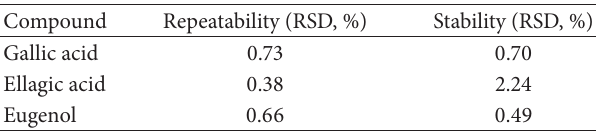
Table 4: Repeatability and stability of three reference compounds in Syzygium aromaticum extract ( 𝑛 = 5 ).